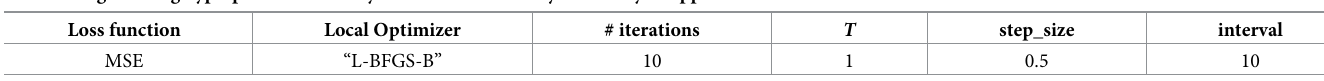
Table 3. Edge finding hyperparameters for synthetic network and yeast cell cycle applications.